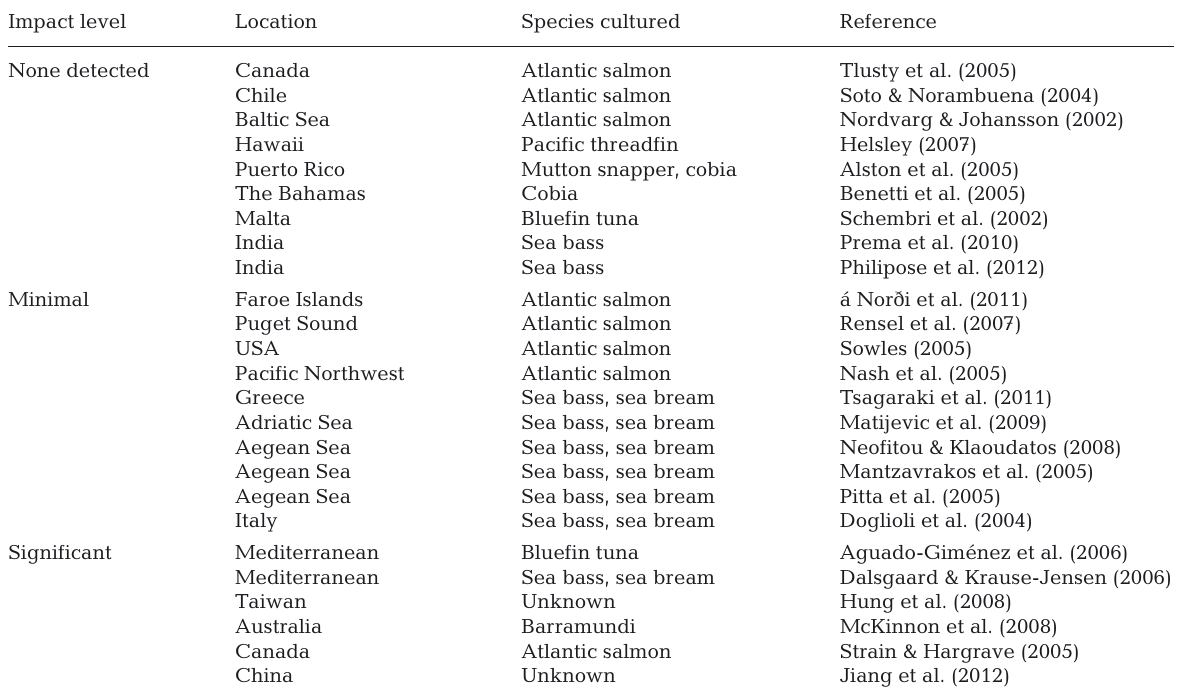
Table 2. Levels of dissolved nitrogen discharge reported and modeled at fish cage sites. At sites with minimal impact levels, the authors reported measurable increases in dissolved nitrogen, but these were statistically insignificant or were not thought to have significant environmental